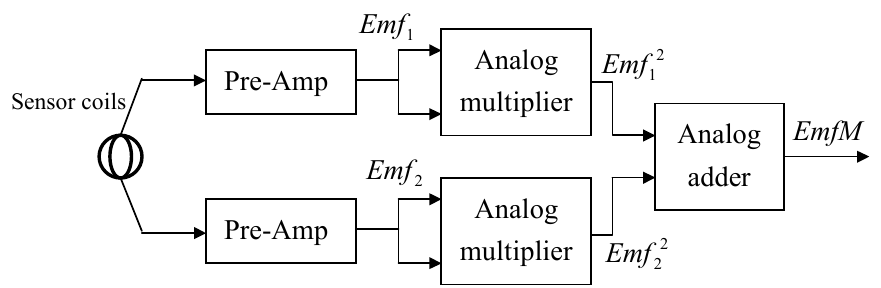
Figure 15. Hardware implementation of the sensor